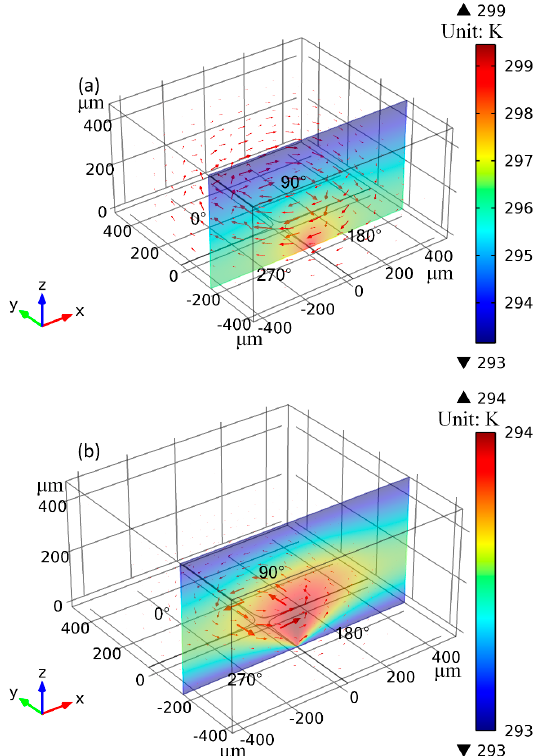
Figure 4. Influence of external natural convection-induced cooling of the gold microelectrodes on temperature field distribution and rotating direction of the central TWET whirlpool (unit: K). ( a ) A volumetric arrow plot of electrothermal flow field and x - z cross-sectional surface plot of internal temperature field at y = − 200 μ m by ignoring the exchange heat flux on the electrode pads, where the anti-field induction vortex rotates clockwise; ( b ) Under the influence of evident electrode cooling, out-of-phase induction EHD streaming transits from repulsion-type to attraction-type which is in the counterclockwise direction of signal-phase propagation.